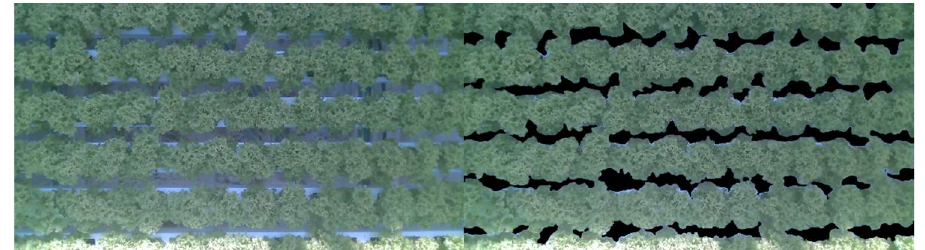
Figure 13. Example of a real ( left ) and segmented ( right ) image using DeepLabv3+. From the segmentation, the coverage [%] was calculated.